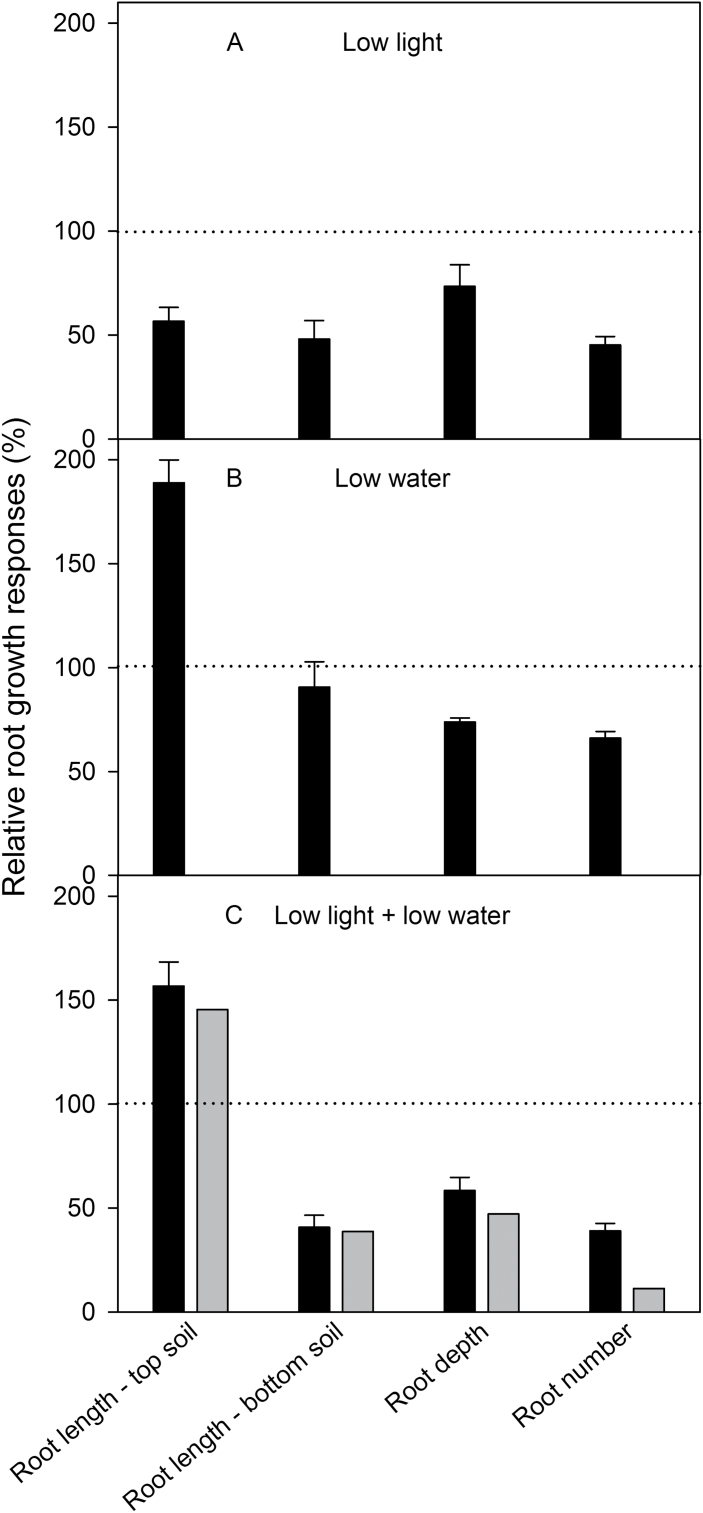
Summary of root growth responses of VJ 10 wheat plants to leaf irradiation and soil moisture 20 days after germination. Ratio between plants exposed to control conditions (moderate light and well watered) and the other three treatment combinations: (A) reduction in light intensity; (B) reduction in soil moisture; and (C) reduction in both light and soil moisture; quantified for root length in the top and bottom part of the rhizoboxes, root depth, and number of lateral roots. Values prior to plants exposed to control conditions were set to 100% (mean value ±SE, n = 4). Additionally, the theoretical root growth reduction under low light combined with low soil moisture (grey bars, C) was calculated as the sum of relative growth reductions under low light and the relative growth reductions under low soil.